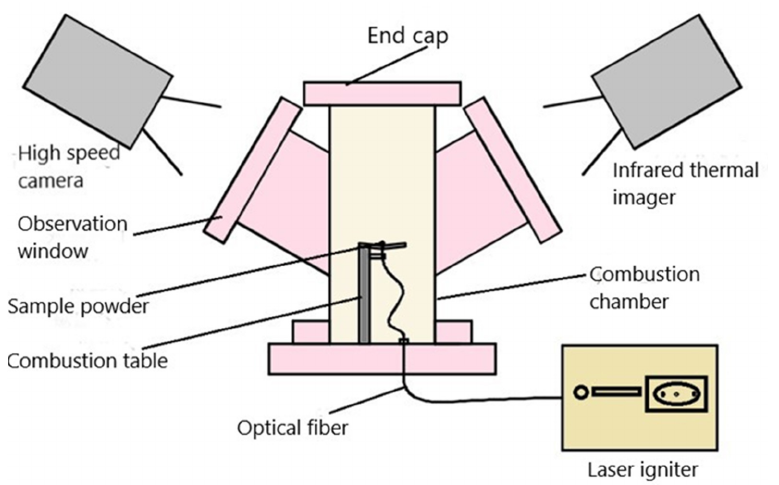
Figure 2. Schematic diagram of laser ignition experimental system.